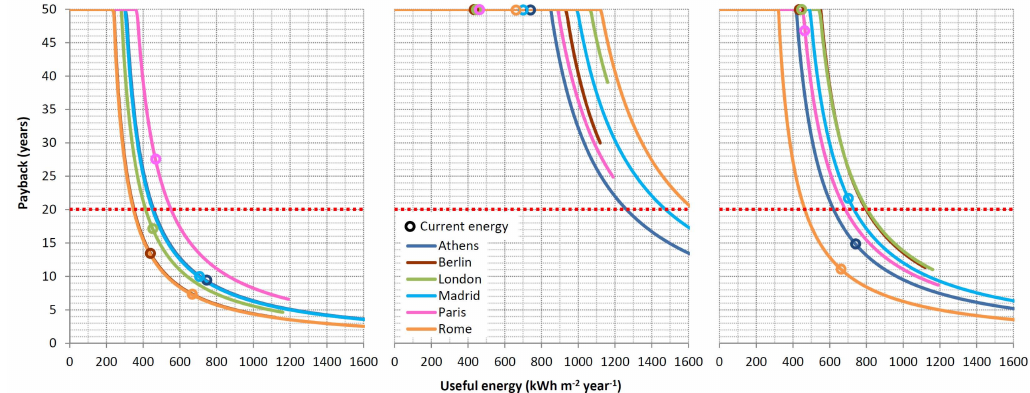
Figure 10. Payback variations produced by changes in the energy supplied by the